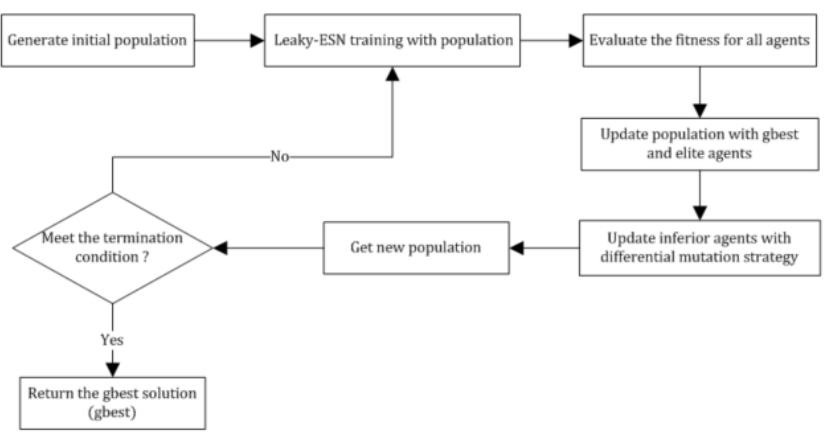
Figure 9. The process of reservoir parameter selection based on the IGSA.